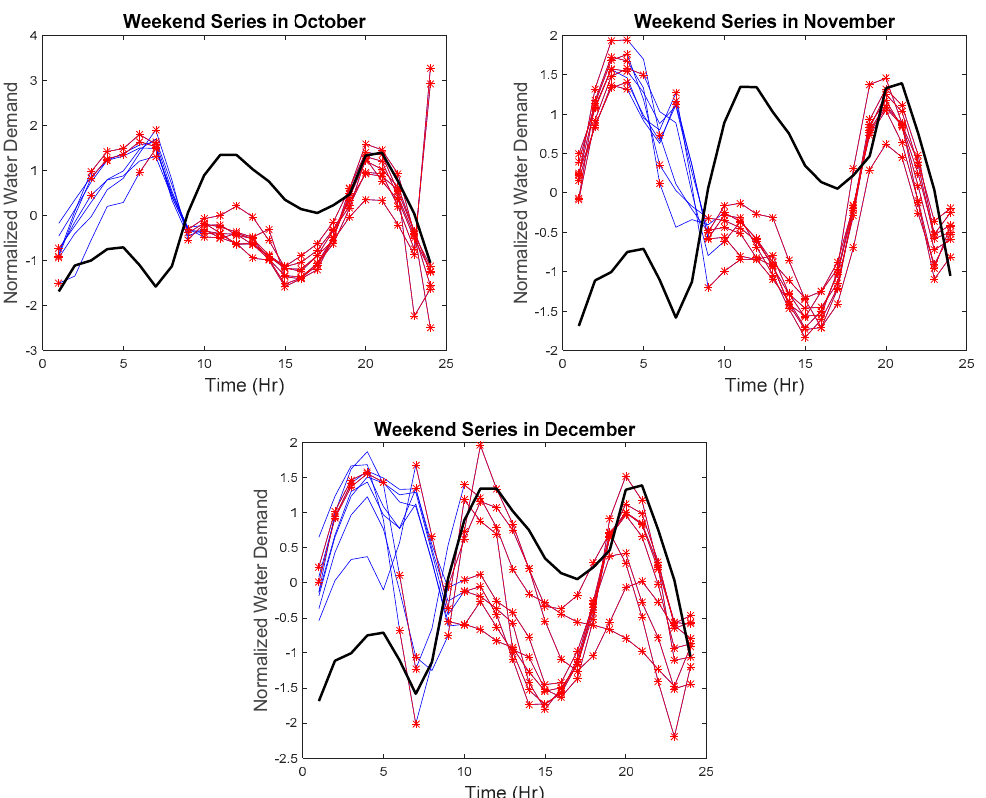
Figure 13. Normalized weekend series with detected anomalies (October–December).